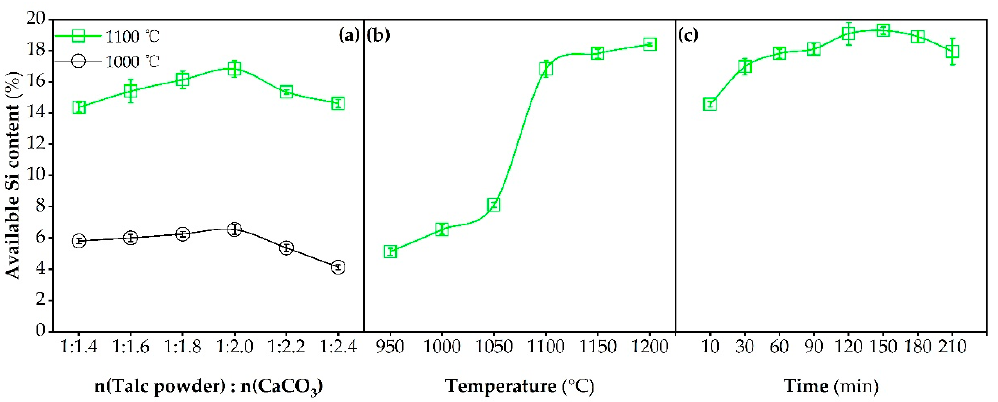
Figure 1. Effects of the ( a ) molar ratio of talc powder to CaCO 3 (1:1.4–1:2.4), ( b ) calcination temperature (950–1200 ◦ C) and ( c ) calcination time (10–210 min) on available Si contents of the prepared Si fertilizers. In plot ( a ), calcination time = 60 min; in plot ( b ), calcination time = 60 min, n(Talc powder): n(CaCO 3 ) = 1:2.0; in plot ( c ), calcination temperature = 1150 ◦ C, n(Talc powder): n(CaCO 3 ) =